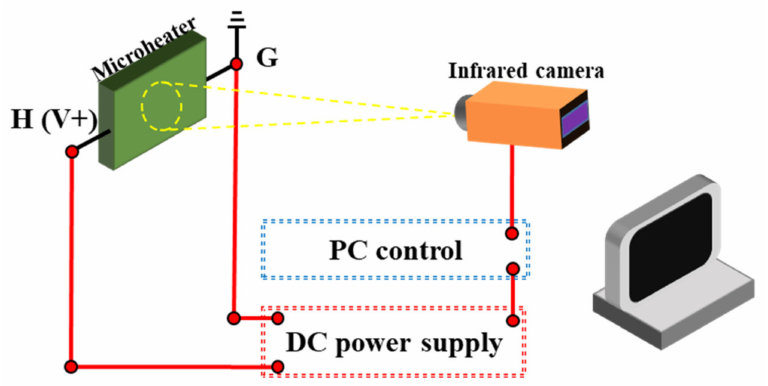
Figure 4. Schematic of microconstruction heating